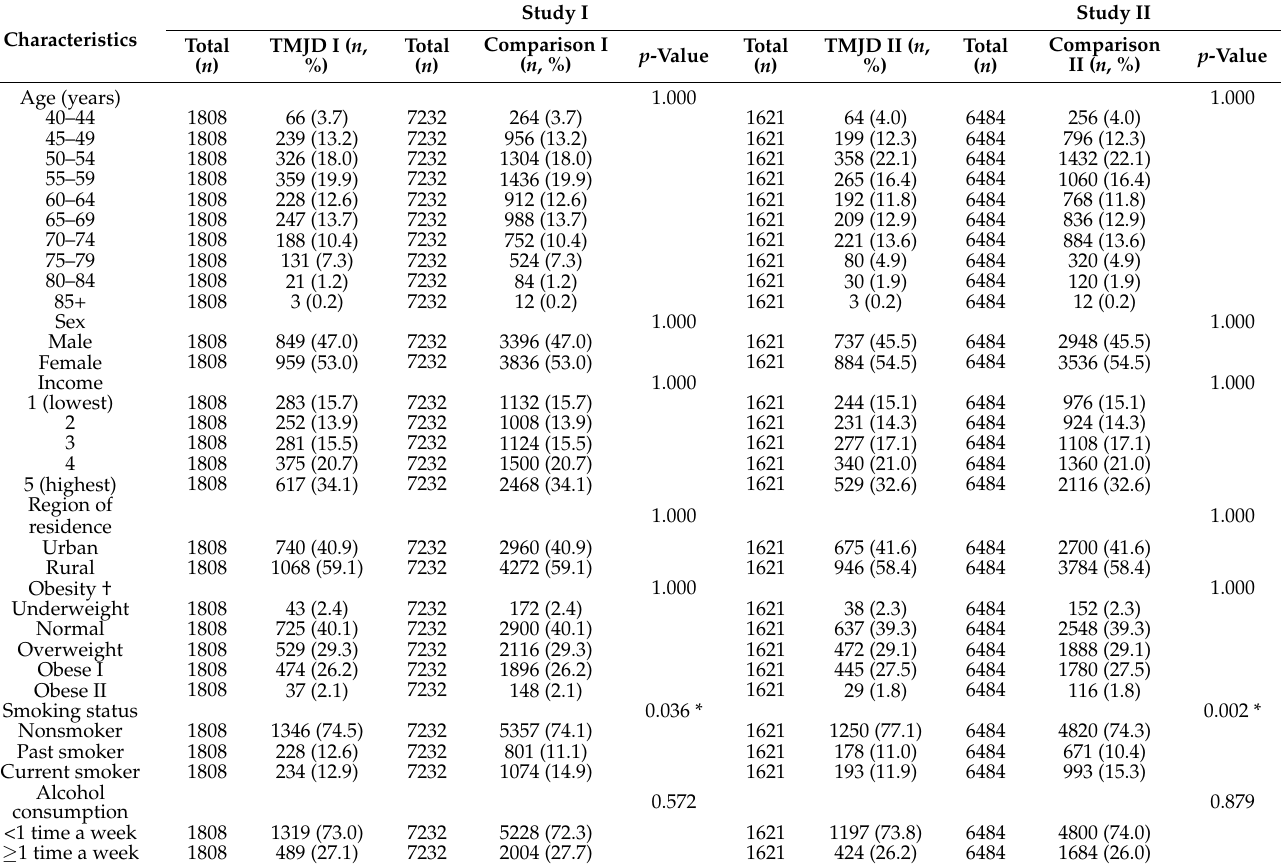
Table 1. General characteristics of